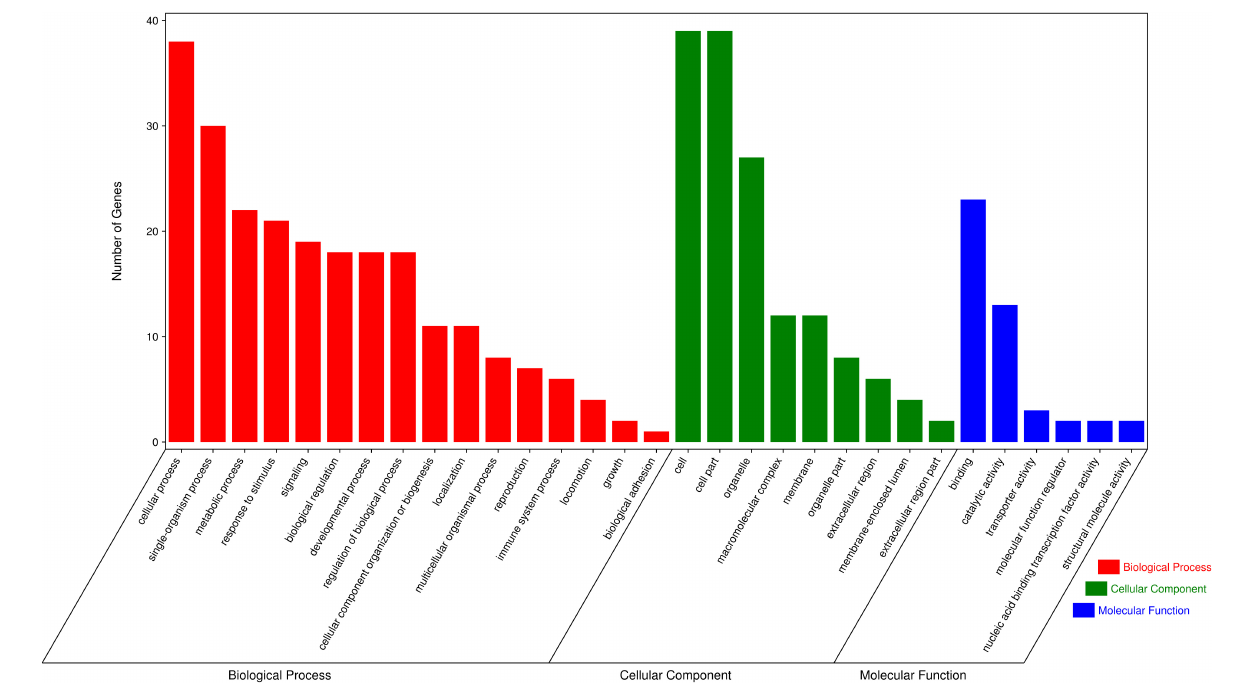
FIGURE 5 | Gene Ontology (GO) terms of the selected genes, red referring to biological process, green referring to cellular component and blue referring to molecular function.